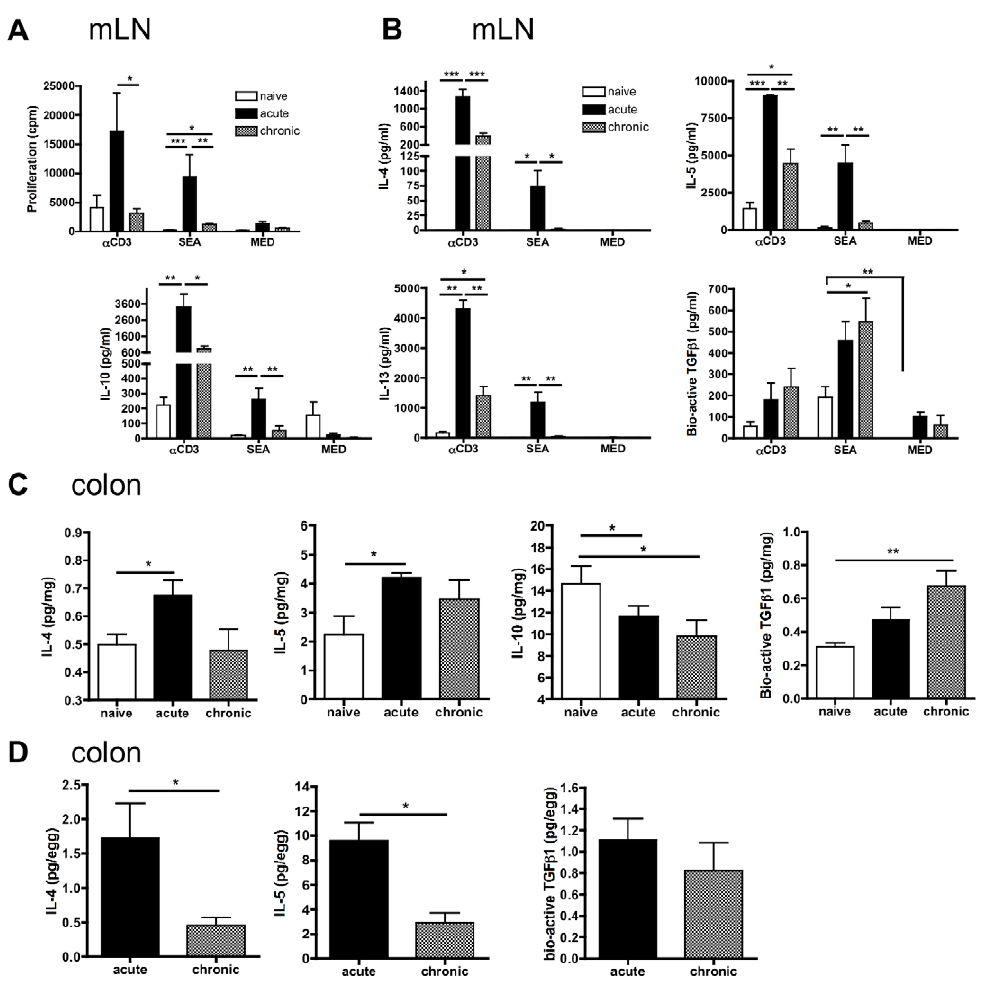
Figure 2. Egg antigen-specific Th2, but not TGF- b 1 responses become down-modulated within the mLN and colon during chronic infection. A ) Proliferative responses and B ) cytokine release (pg/ml) by mLN cells from naı¨ve, acute, or chronic mice (n=4/group) to anti-CD3 mAb, or SEA. C ) Cytokine levels within colonic tissues (pg/mg tissue) and D ) adjusted for numbers of eggs / mg of tissue. Data are mean proliferative response / cytokine concentration 6